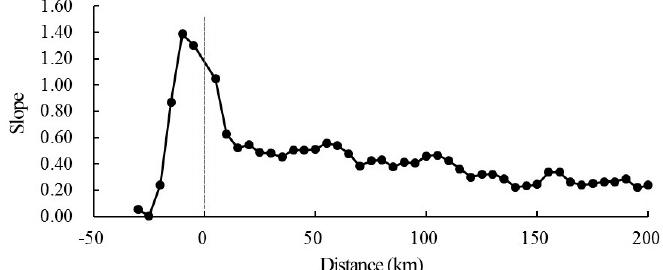
Figure 7. Speed of change in urban development inside and outside the inequality boundary in Beijing-Tianjin-Hebei urban agglomeration during 2000–2012.